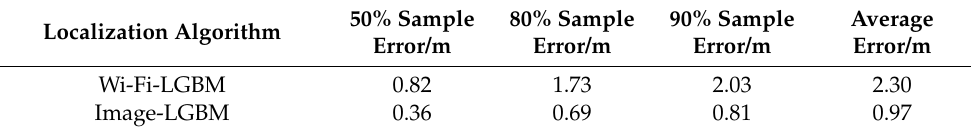
Table 2. Comparison of average positioning error for a single-fingerprint dataset.